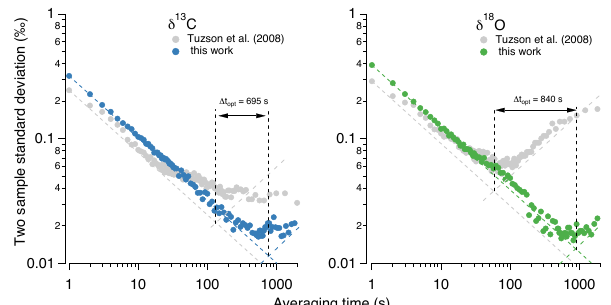
Fig. 2. Two-sample standard deviation (Allan deviation) of cylin- der air measurements for δ 13 C and δ 18 O. The stability performance of the upgraded instrument (colored markers) is compared with the values reported for this spectrometer by Tuzson et al. (2008a) (gray markers). The slight degradation in precision at 1s averaging time is largely compensated by the higher stability at longer timescales (as indicated by 1t opt ). The optimum averaging time ( t opt ) is reached after ∼ 12min for both isotope ratios, corresponding to an analyt- ical precision of 0.02‰. The white and drift noise influenced do- mains are indicated by gray and colored dashed lines.